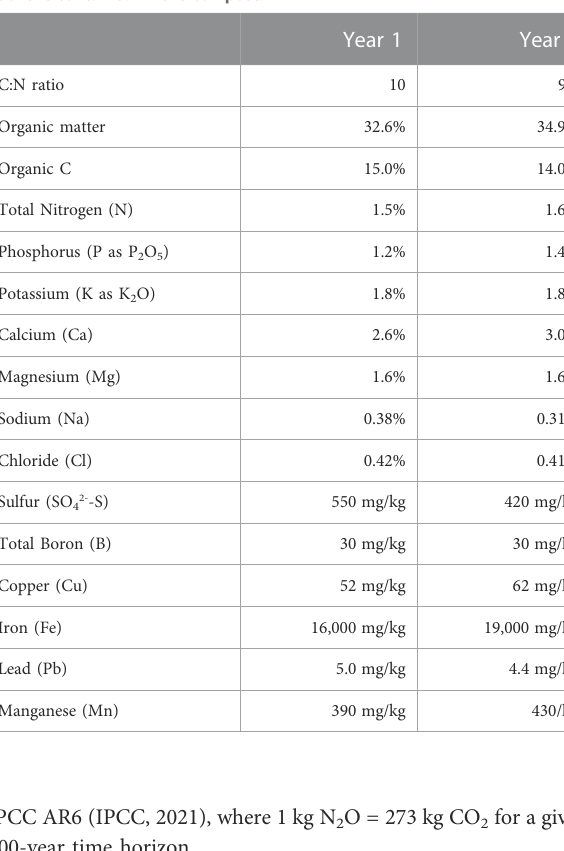
TABLE1Propertiesofthecerti fi edorganiccompostappliedinNovember2018 (Year 1) and January 2020 (Year 2). Values represent the dry weight of each nutrient contained in the